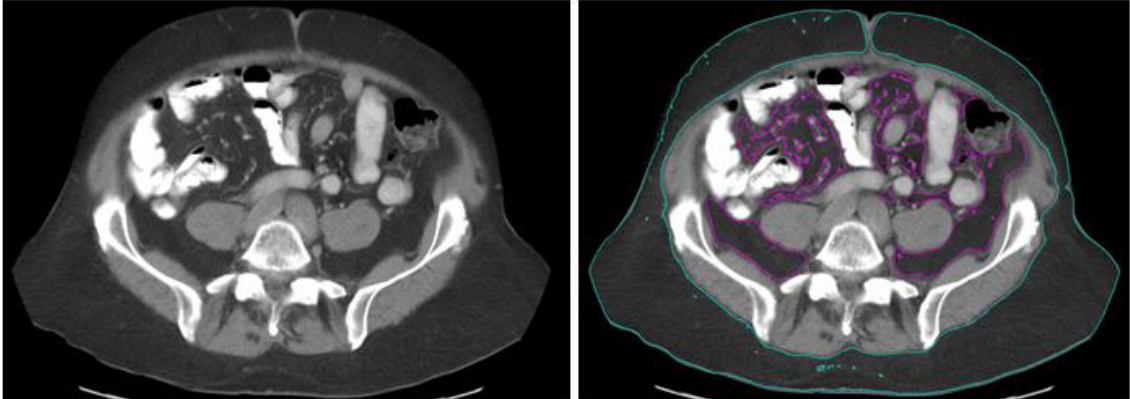
Figure 1. Measurement of intra-abdominal fat area by use of computed tomography. ( Left ): Initial computed tomography images. ( Right ): Intra-abdominal adipose tissue areas. Regions of purple and blue color indicate visceral (89.4 cm 2 ) and subcutaneous (246.6 cm 2 ) adipose tissue, respectively.